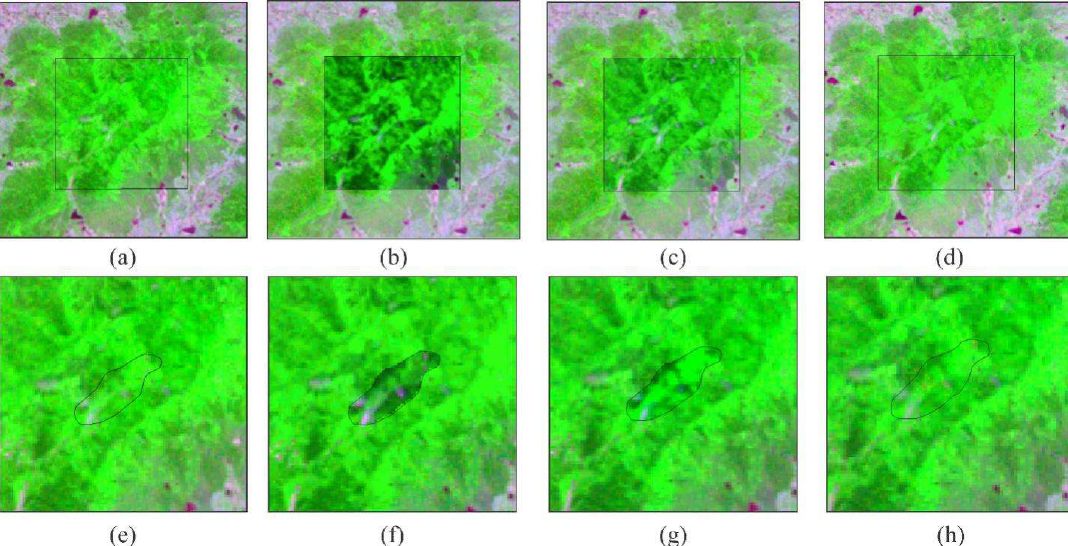
with the other two methods.